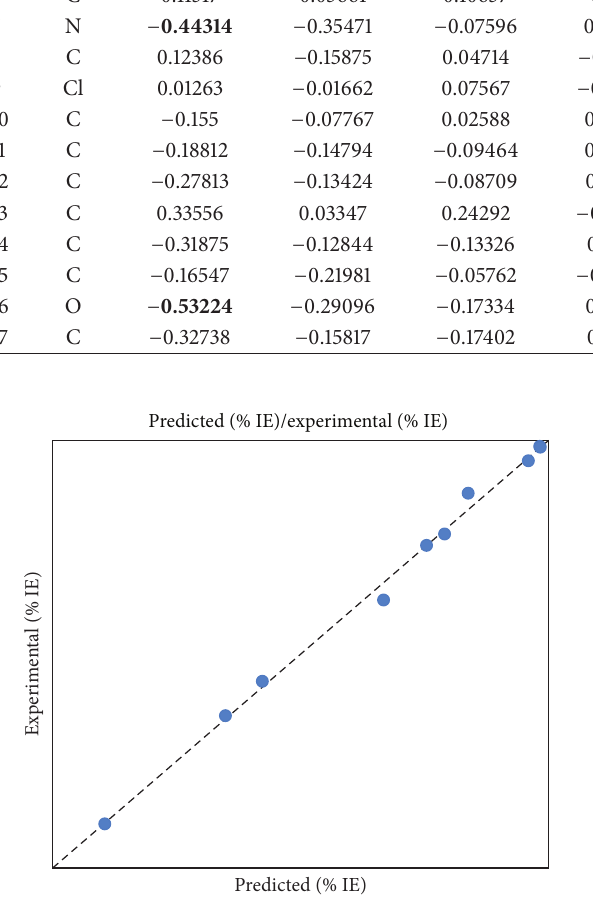
Figure 5: Experimental and predicted (% IE) of studied inhibitors by using regression